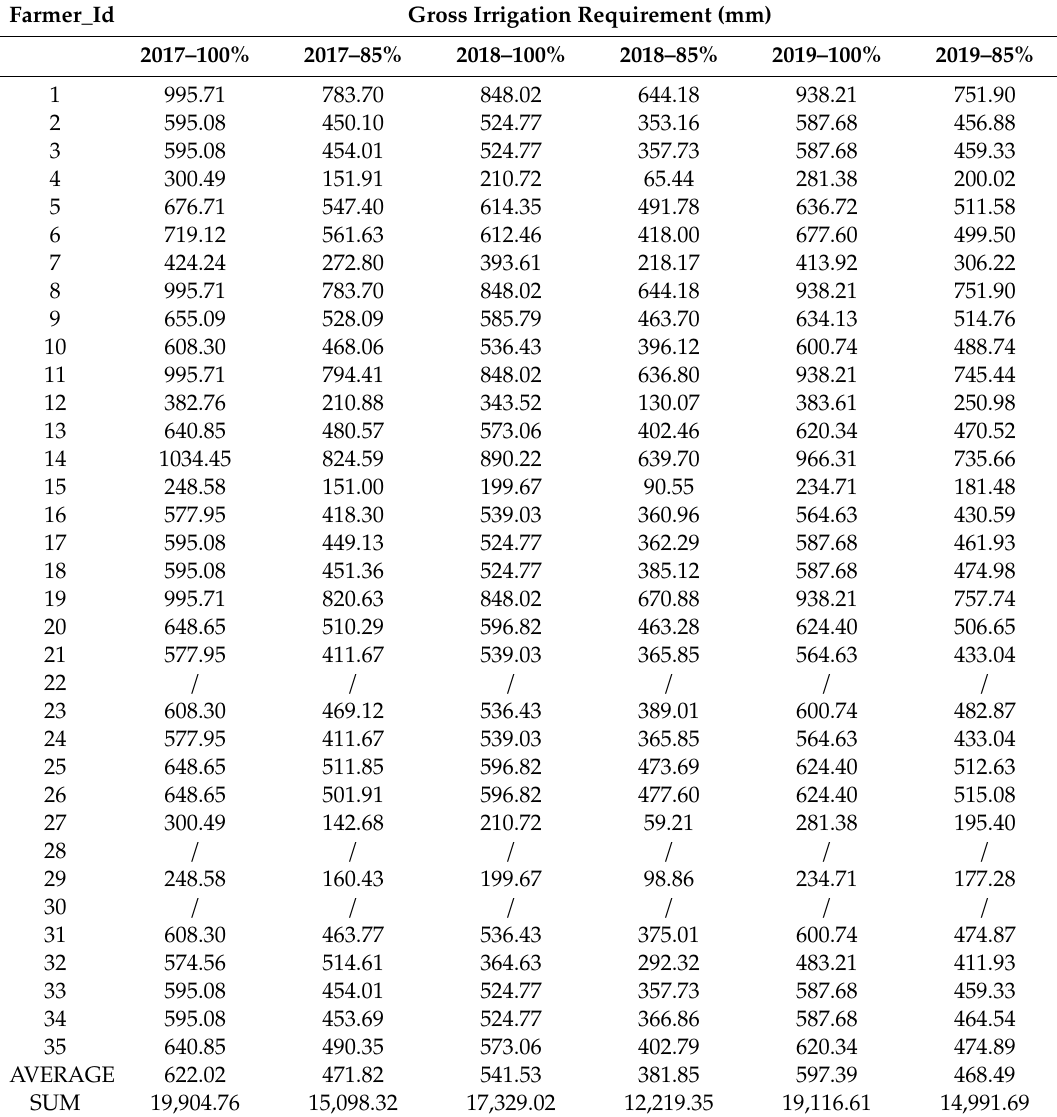
Table A5. Yearly gross irrigation requirement (mm) at farm level by replenishing soil water content to (i) FC and (ii) to 85% capacity